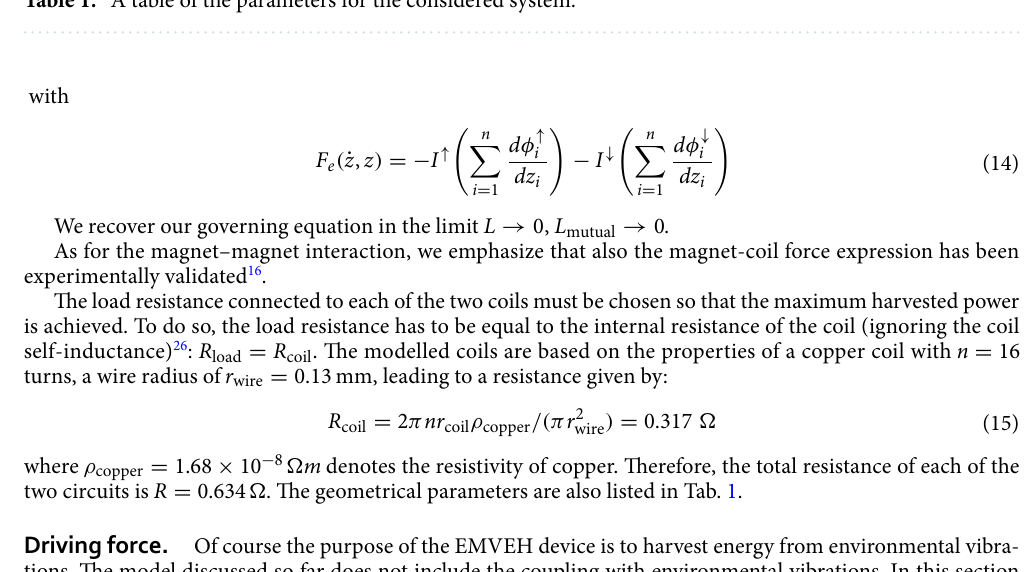
Table 1. A table of the parameters for the considered